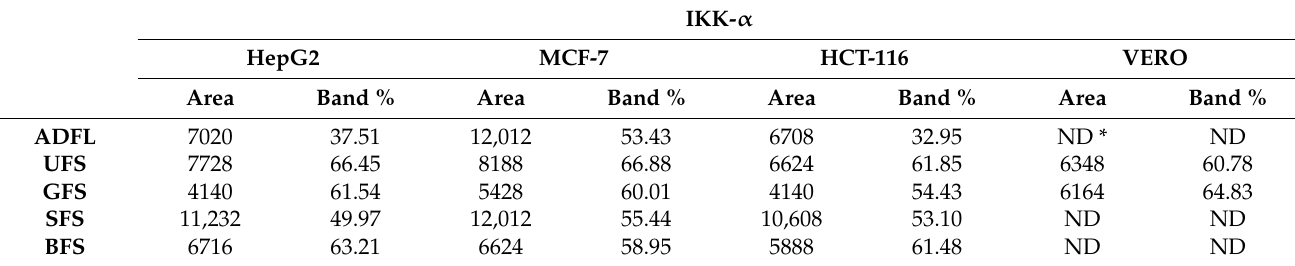
Table 6. Protein expression levels of IKK- α in HepG2, MCF-7, HCT-116, and VERO cell lines exposed to IC 50 of air-dried fenugreek leaves (ADFL), unprocessed fenugreek seeds (UFS), germinated fenugreek seeds (GFS), soaked fenugreek seeds (SFS), and boiled fenugreek seeds (BFS).